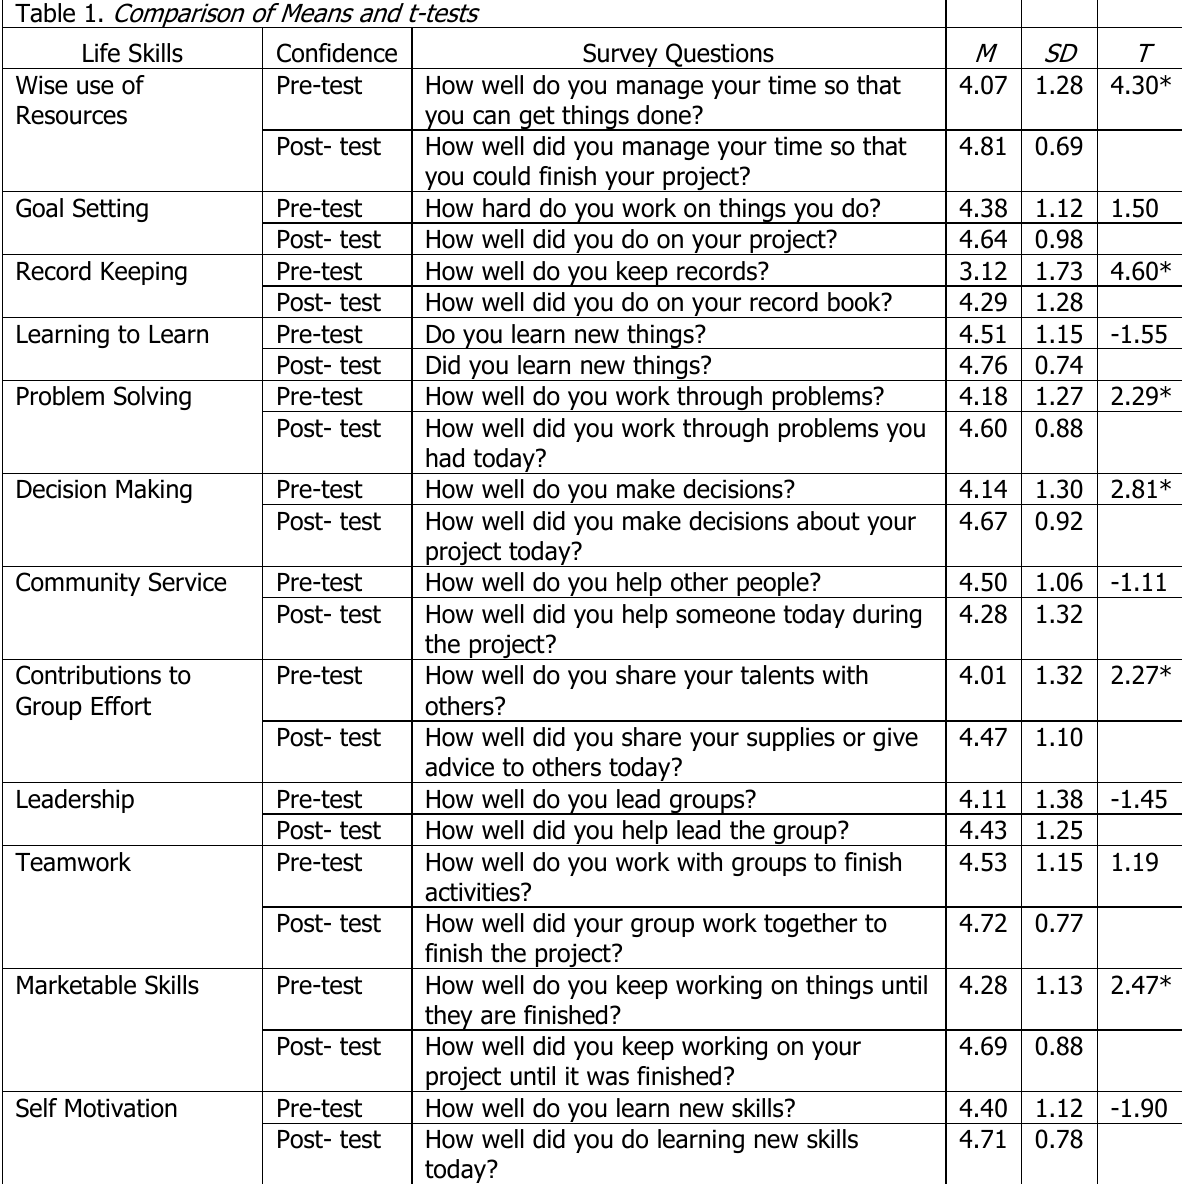
Comparison of Means and t-tests N=72 Table 1.